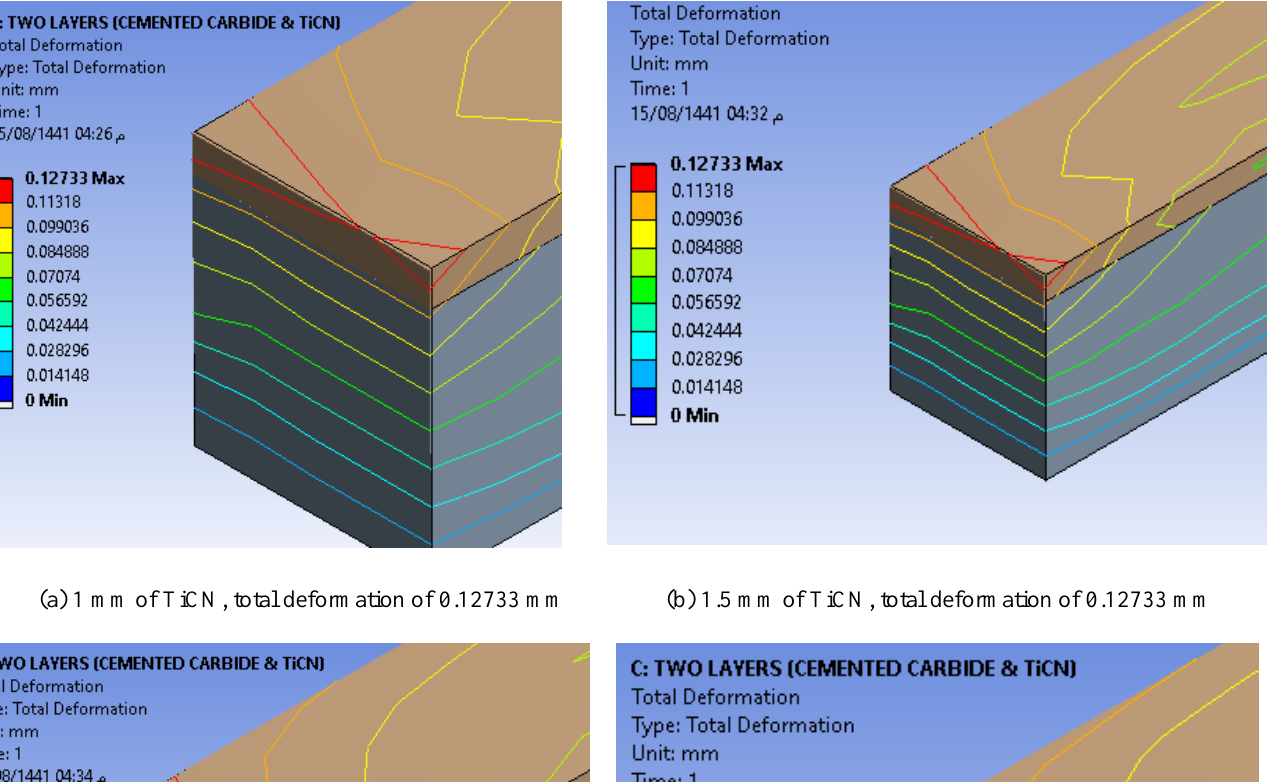
Fig. 22. Total deformation of cemented carbide and TiCN beam with thermal condition of 500 °C